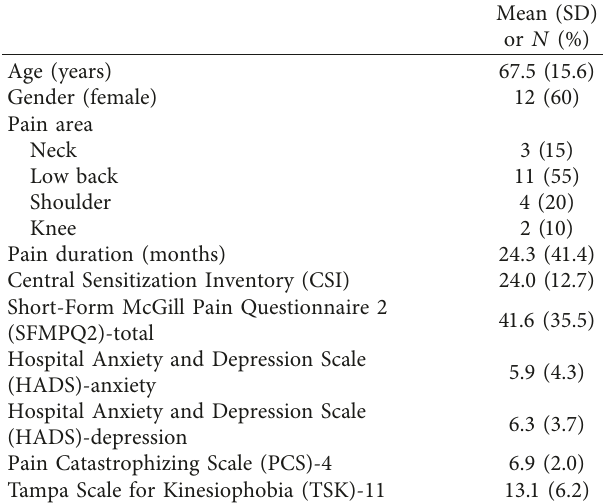
Table 1: Characteristics of the